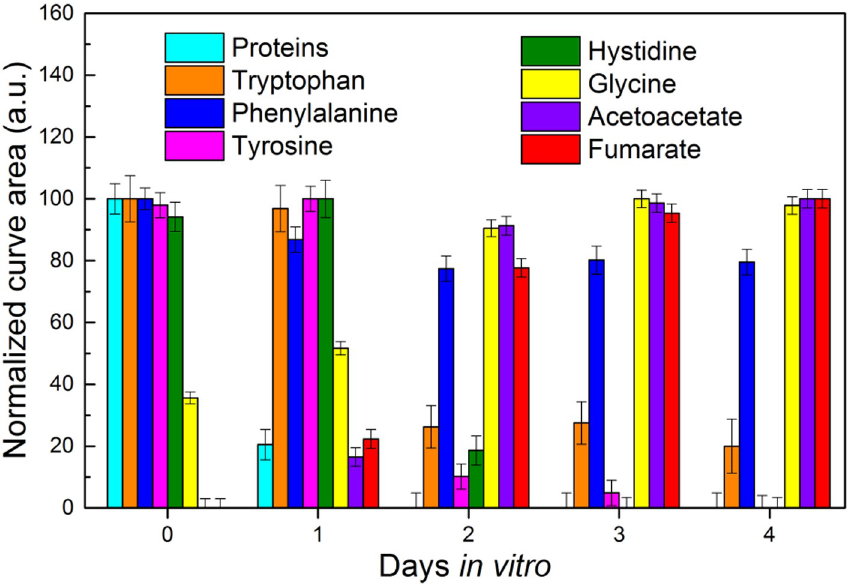
Fig 5. Analysis of the intensity for multiple Ramanpeaks of the cell conditioned medium. The normalized integralcurve areas of peaks correspondingto different analytespresent in cell culture medium are reportedfrom DIV0 to DIV4. Each color correspondsto a different